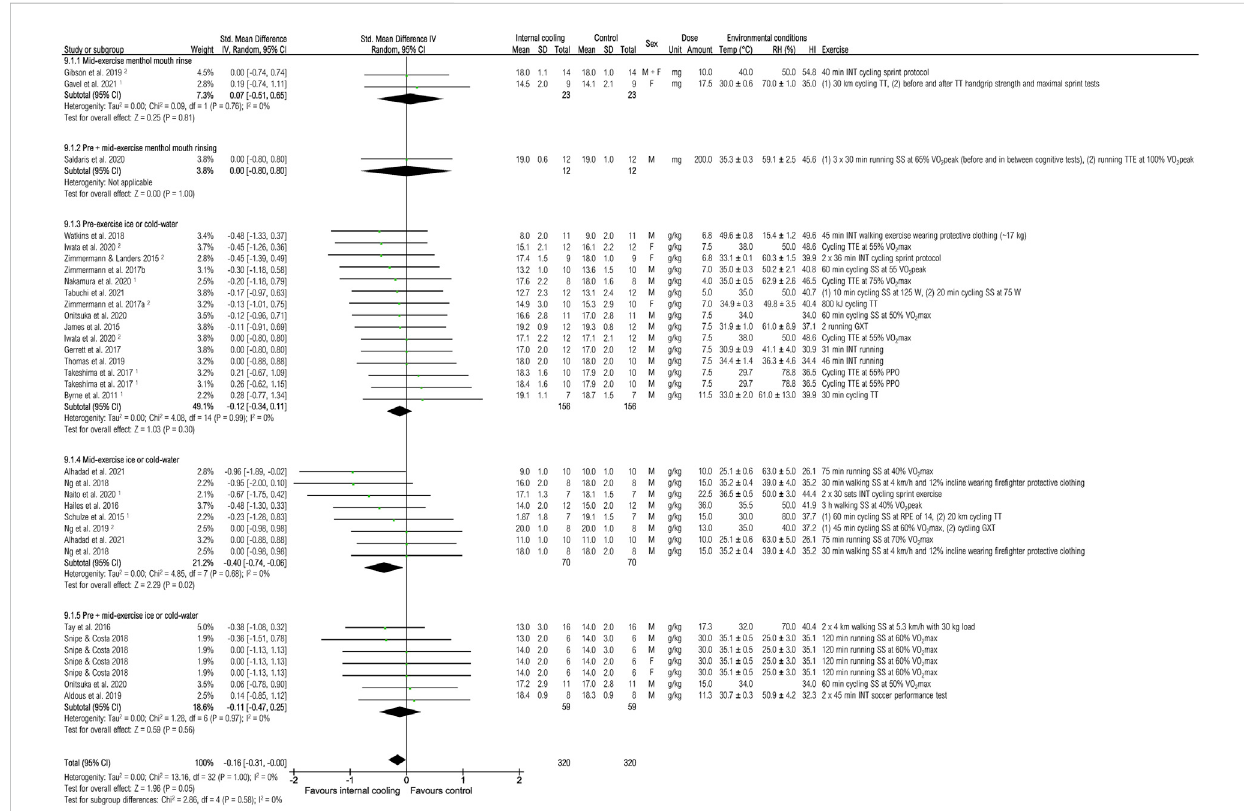
FIGURE 10 Meta-analysis of standardized mean difference in rate of perceived exertion with 95% CI between internal cooling and control. 1 Studies with signi fi cantpositiveperformanceeffectsofinternalcooling. 2 Studieswithnoperformanceeffectsofinternalcooling.F,female;GXT,gradedexercisetest; HI, heat index; INT, intermittent exercise; M, male; PPO, peak power output; RH, relative humidity; RPE, rate of perceived exertion; SS, steady-state exercise; Temp, ambient temperature; TT, time trial; TTE, time to exhaustion; VO 2 max, maximum oxygen consumption; VO 2 peak, peak oxygen